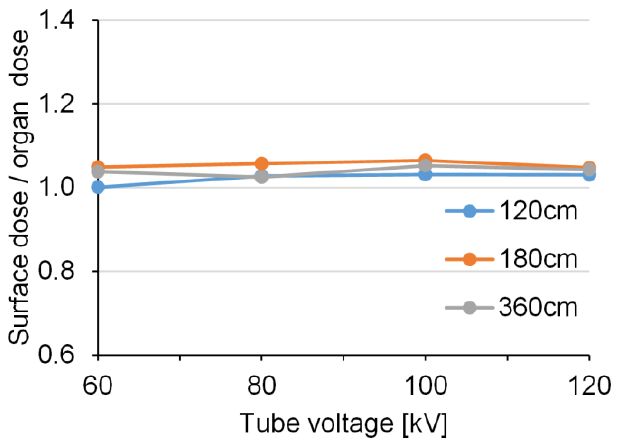
Figure 6. The relative values of the measured breast surface doses (BSDs) and the calculated breast organ doses (BODs) in the anteroposterior (AP) view (without a grid).